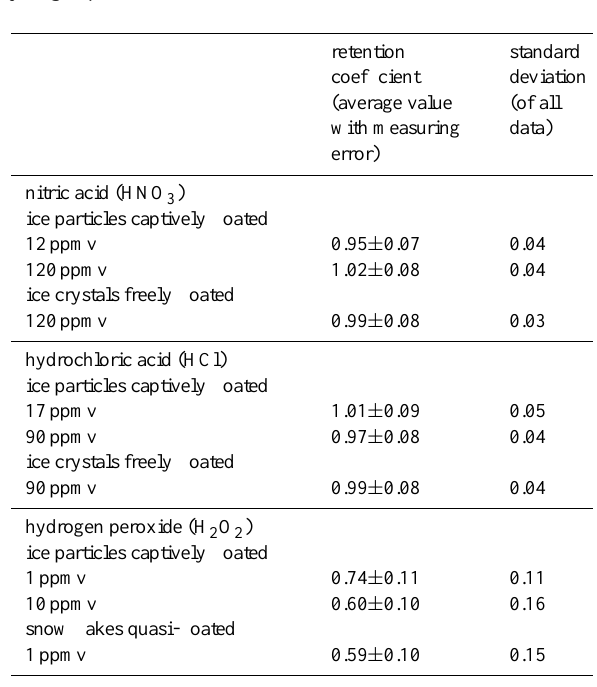
Table 2. Retention coefficients of nitric and hydrochloric acid and hydrogen peroxide.